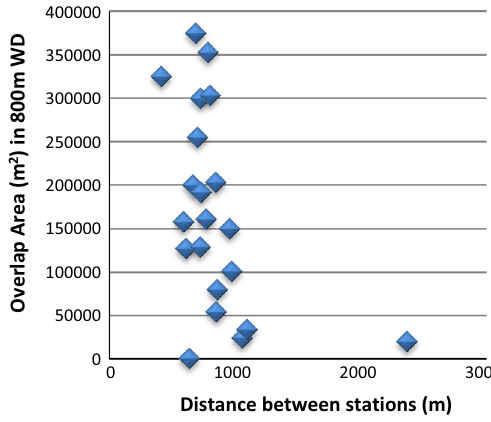
Fig. 2 Scatter plot of overlap area versus distance between stations